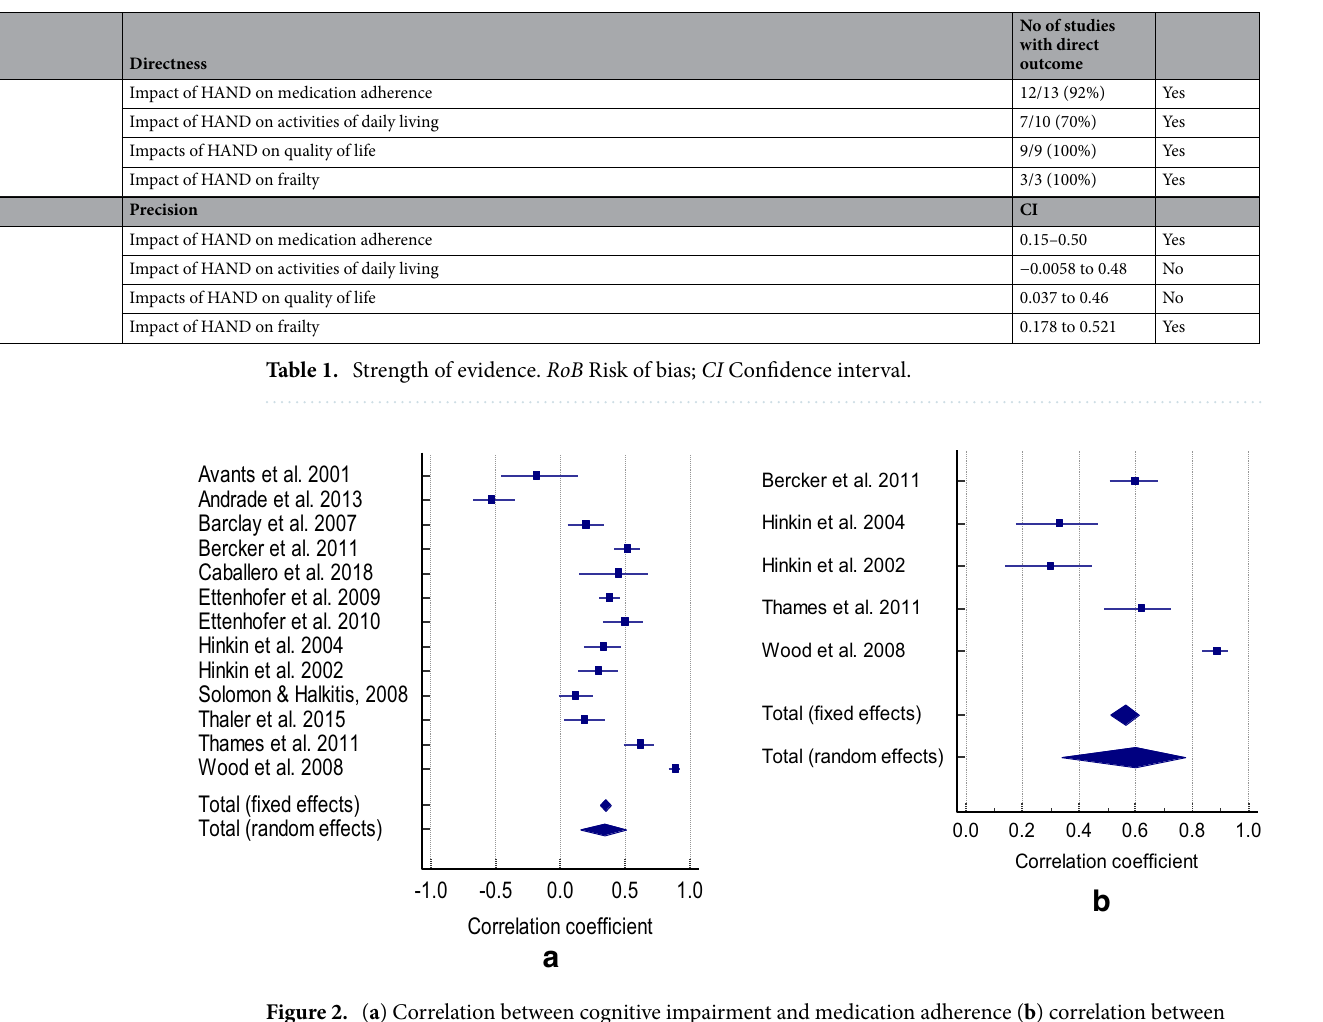
Figure 2. ( a ) Correlation between cognitive impairment and medication adherence ( b ) correlation between cognitive impairment and medication